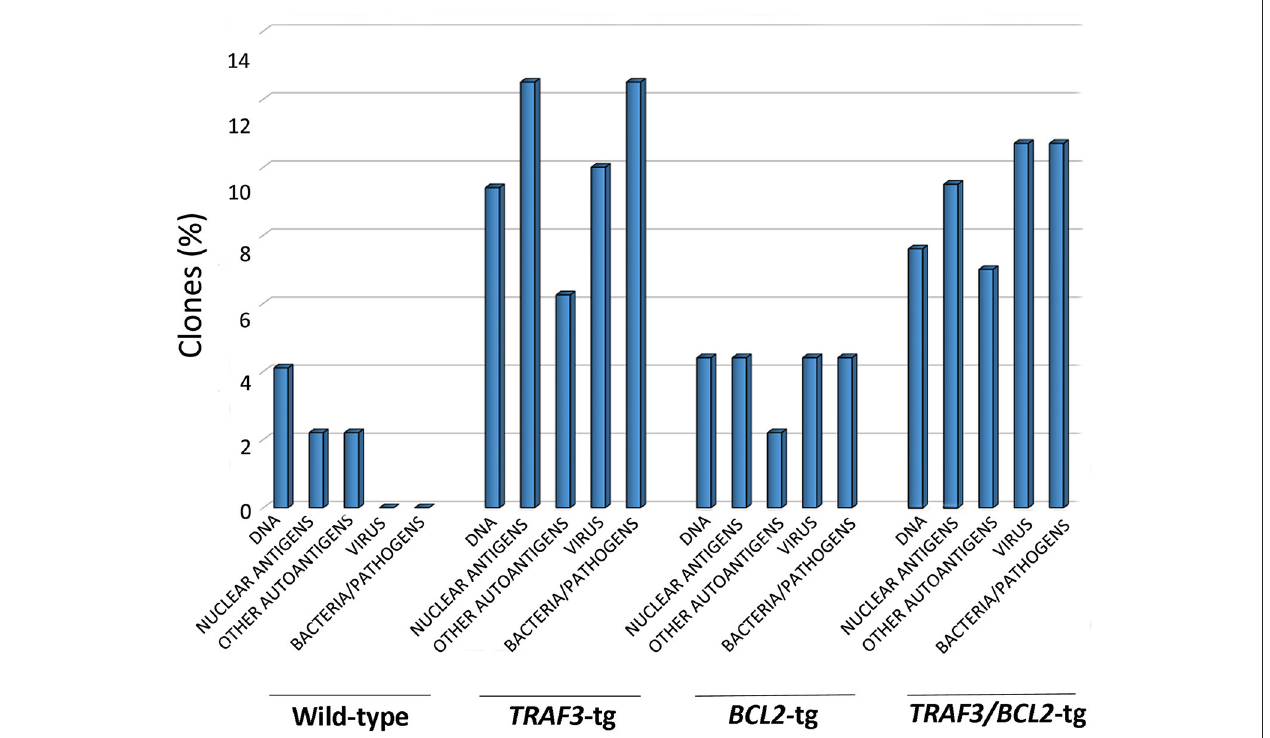
FIGURE 5 | TRAF3 upregulation increases the incidence of immunoglobulins with HCDR3 sequences potentially reactive to autoantigens and PAMPs. HCDR3 sequences were analyzed by blastp (non-redundant protein sequences from Mus musculus ) and those showing ≥ 75% identity to described sequences recognizing DNA, ANAs, other autoantigens, and PAMPs (virus, bacteria, and other pathogens) were selected. Data represents the percentage of HCDR3 sequences similar to those recognizing the indicated